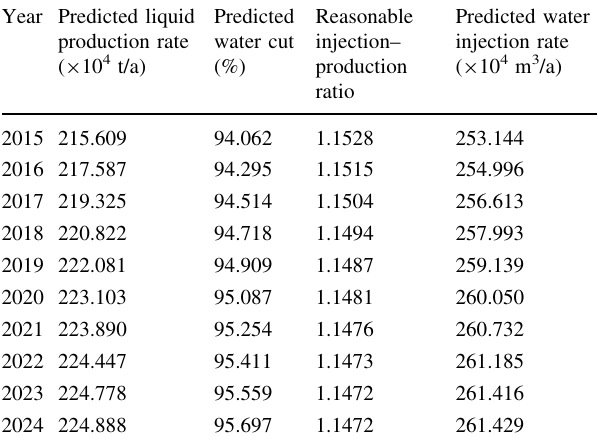
Table 5 Predicted reasonable developing indexes for M oilfield Year Predicted liquid production